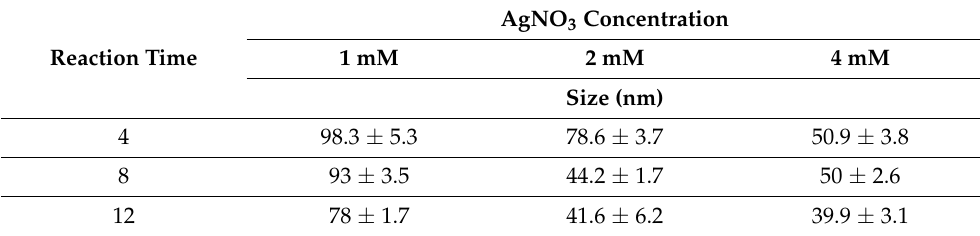
Table 2. Average diameter of the obtained nanoparticles using DLS.